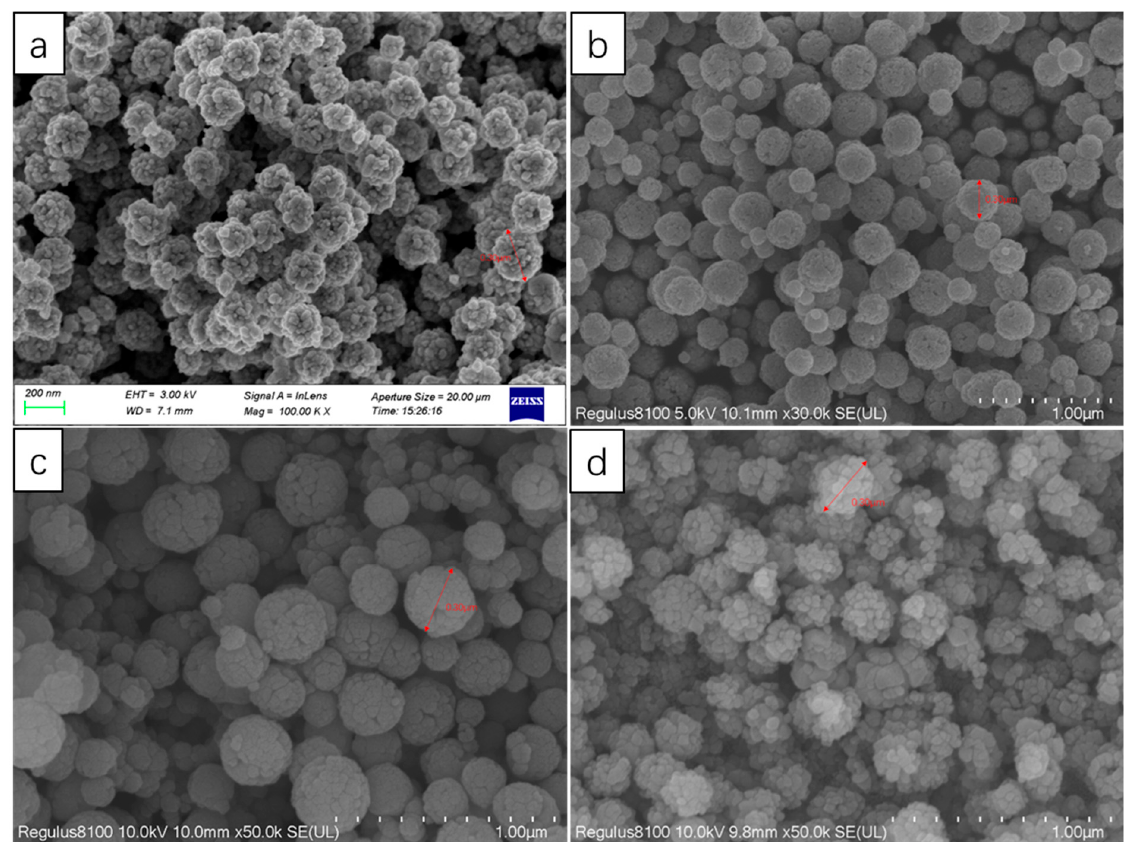
Figure 4. SEM image of Fe 3 O 4 . The times were: ( a ) 6 h; ( b ) 8 h; ( c ) 10 h; and ( d ) 12 h.